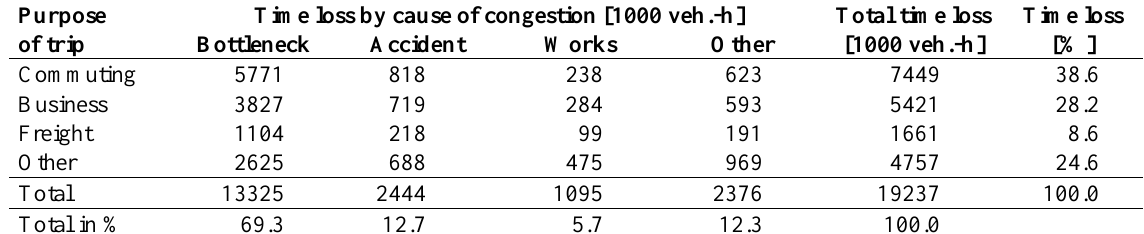
Table 4. Congestion time loss of vehicles in 1997 on Dutch motorways and principal